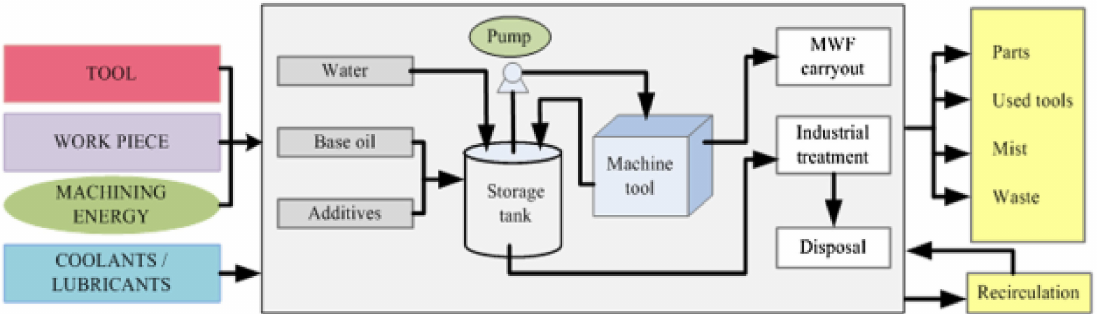
Figure 19. Machining, reprinted from ref. [86]. Copyright 2014 Elsevier